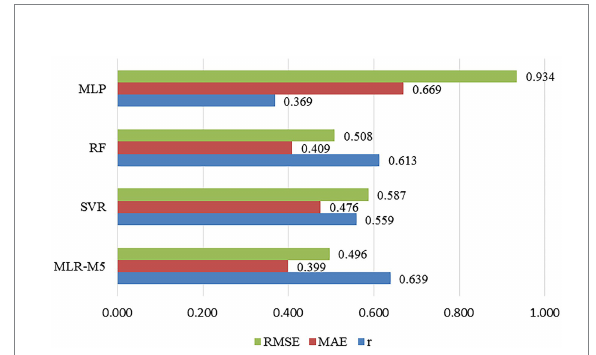
FIGURE 7 The comparison of the regression prediction results of the five machine learning